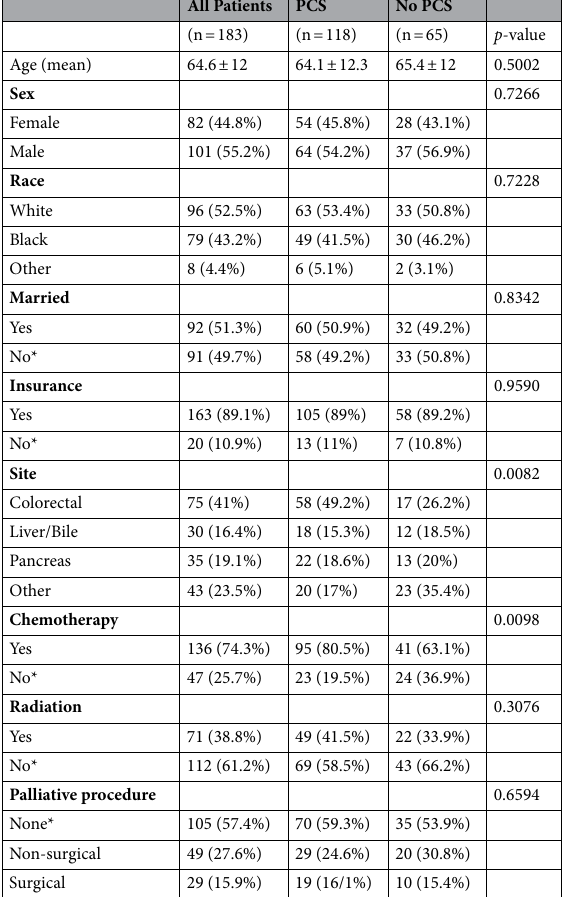
Table 1. Patient characteristics for patients with metastatic hepatopancreaticobiliary and gastrointestinal cancers referred to palliative care services at a single institution, 2014–2018. PCS Palliative care services. *Includes patients with unknown